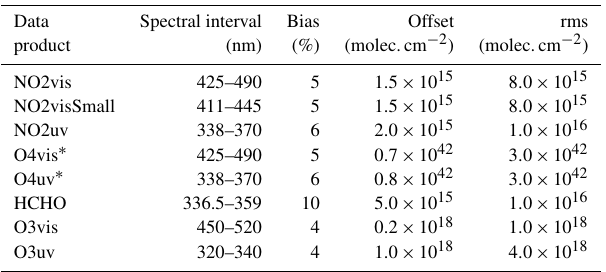
Table 4. Data products included in the semi-blind intercomparison exercise and wavelength intervals selected for the analysis. Perfor- mance limits on bias (deviation from unity slope), offset and rms of dSCD linear regressions are also listed for each of the eight data